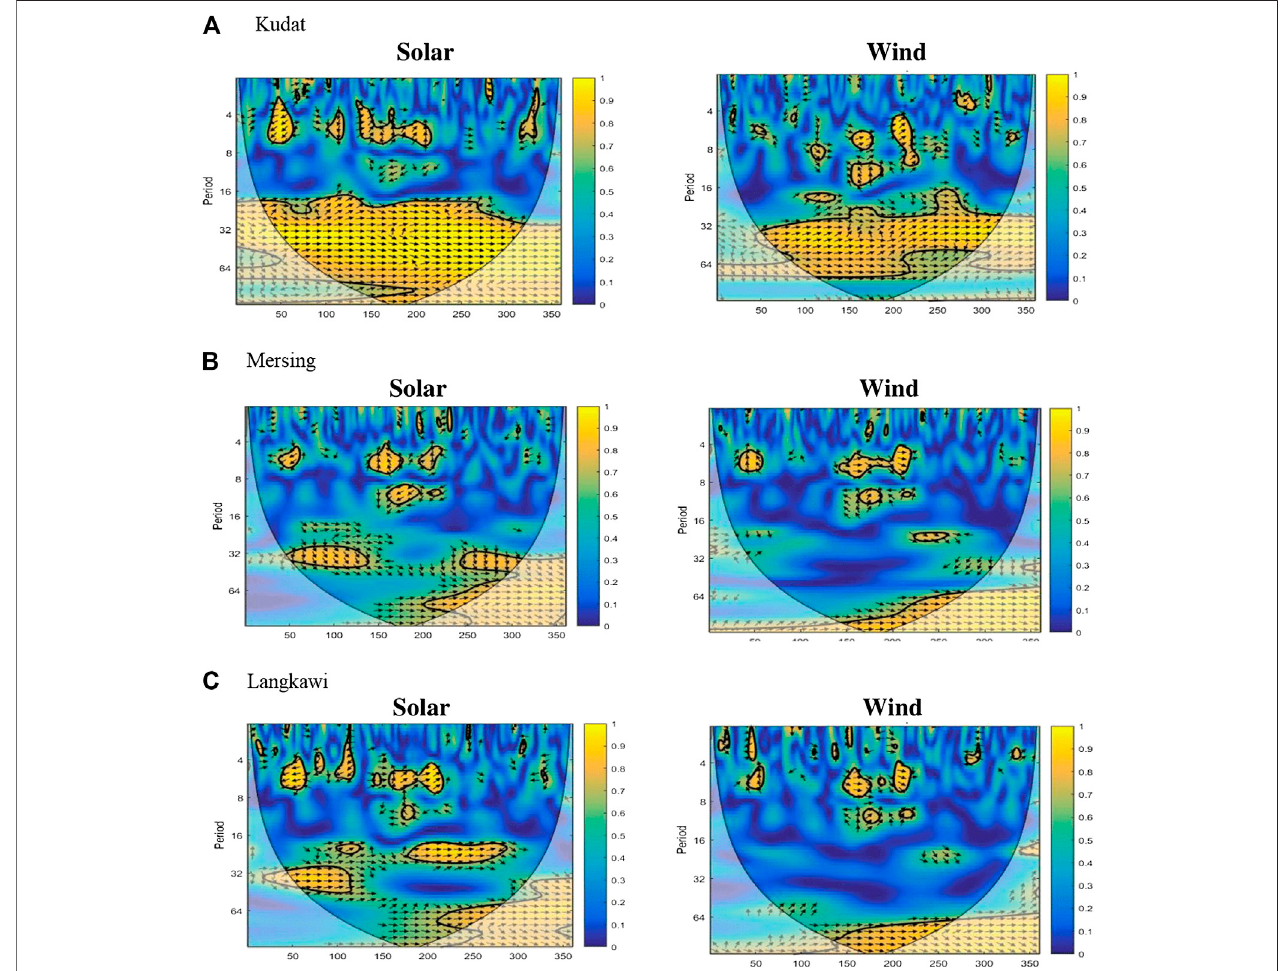
FIGURE 4 | The Wavelet Coherence (WTC) of wind and solar with multivariate ENSO index.